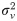
Results of Repli-Sim for HU-treated cells for both constant and variable fork speed models.(a) Some models (parameter sets) considered. Stochasticity of replication forks’ speeds (σv2) is shown on the horizontal axis and residual sum of squares (RSS) with the experimental data of [31] is shown on the vertical axis, the average forks’ speed (v) is color-coded (side bar). Best fitting models (smallest RSS) are characterized by more stochastic forks’ speeds. Best fitting constant speed model is (σt2=11(min2), texp = 52(min), v = 0.07(kb/min), σv2=0(kb/min)2,) the best selected variable speed model is (σt2=7.7(min2), texp = 52(min), v = 0.12(kb/min), σv2=0.07(kb/min)2, pend = 2e − 6). (b, c) The distribution of DNA tracks for both best stochastic (b, orange) and constant (c, blue) forks’ speeds models are shown along with the distribution of DNA tracks from experimental data (gray), which shows a better fit for the stochastic forks’ speeds model.